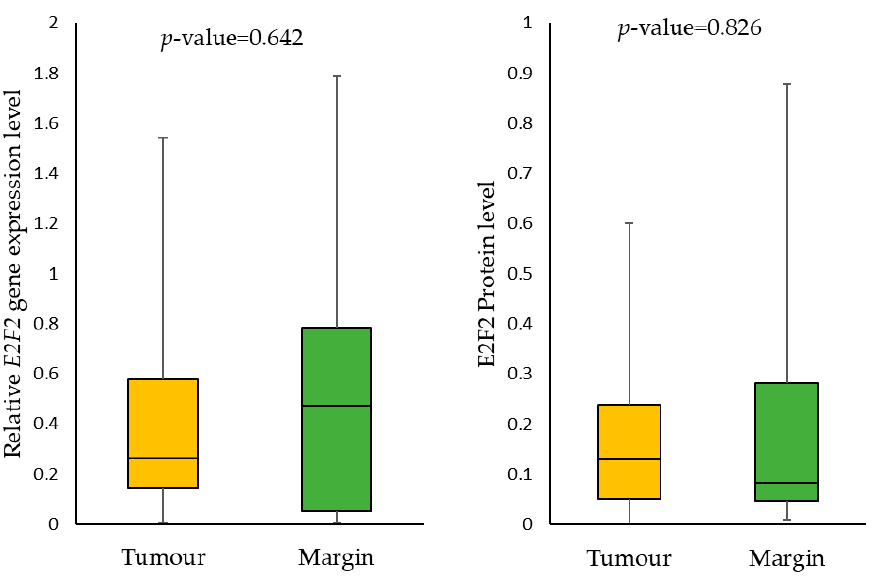
Figure 1 . The E2F2 mRNA expression and E2F2 protein level in tumour and margin samples. 2.3. miR-125b-5p, miR-155-3p, and miR-214-5p Expression in Tumour Samples Compared to Margin Samples Analysis of the relative expression levels of the tested miRNAs demonstrated statis- tically significant levels for only one (miR-155-3p) of the tested miRNAs when comparing tumour versus margin samples. The tests showed that miR-125b-5p ( p -value = 0.235) was